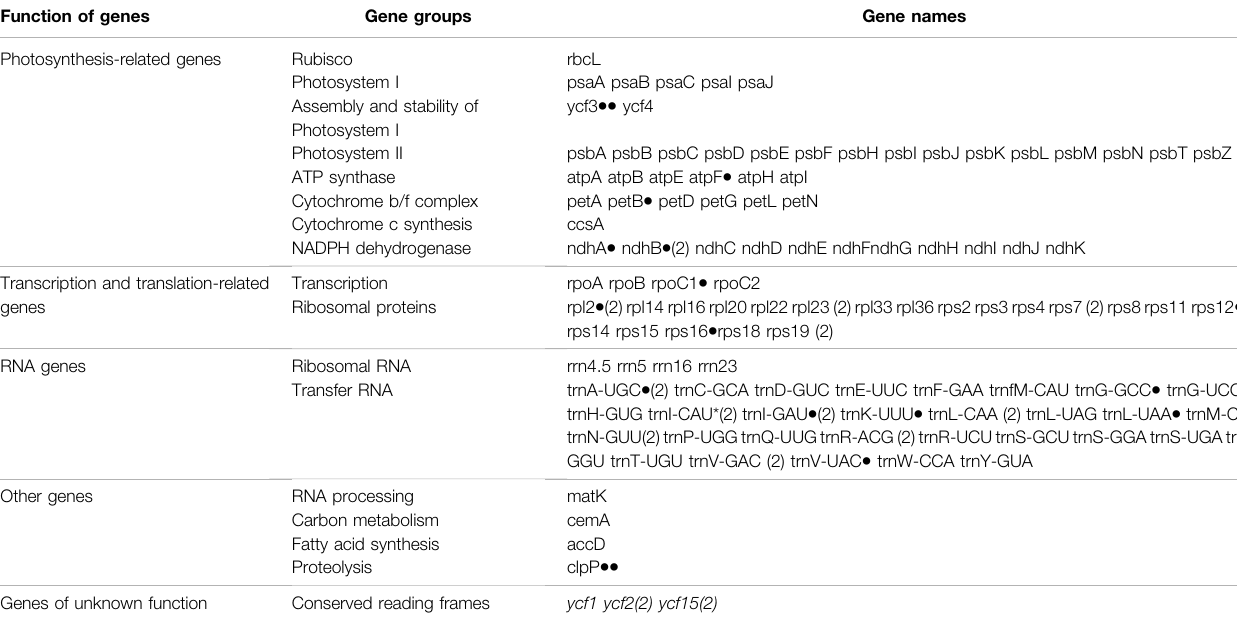
TABLE 3 | The list of genes in the chloroplast genomes of Impatiens species. Function of genes Gene groups Photosynthesis-related